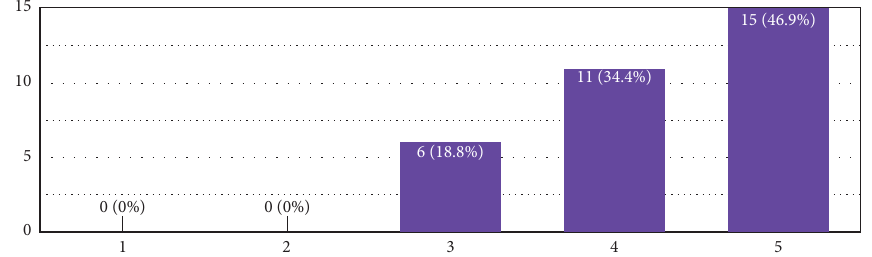
Figure 8: In this fgure, the polarised entry 1 means “theory based” and 5 means “design intervention based;” the remaining are the extrapolations in the middle as per the Likert scale. Te Y -axis shows the number of